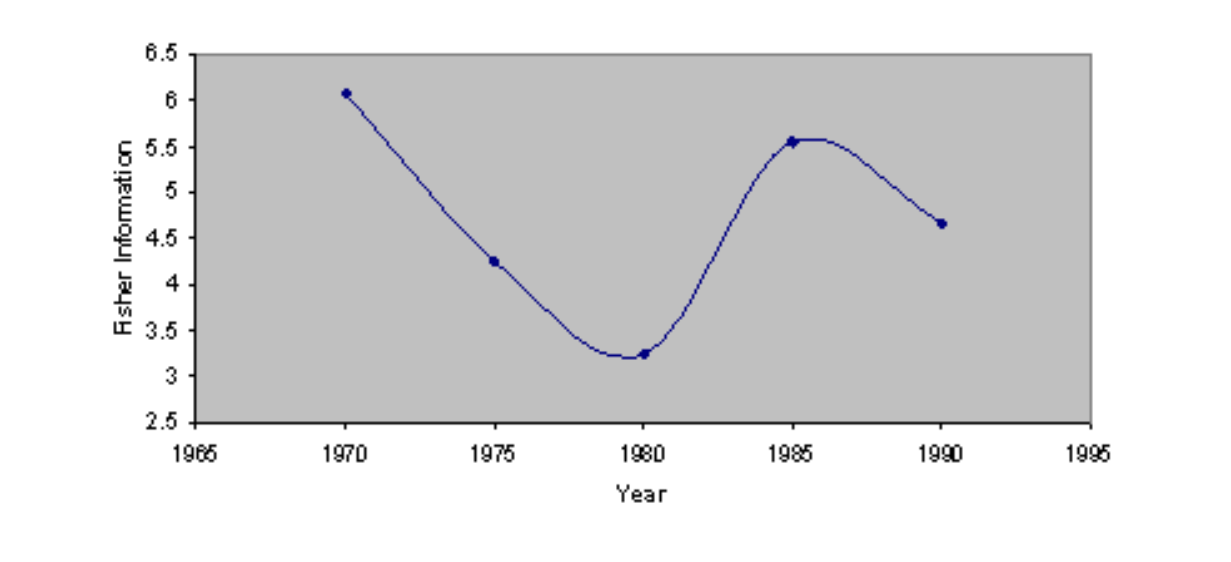
Fig. 5. Fisher information: coupled climate, biological